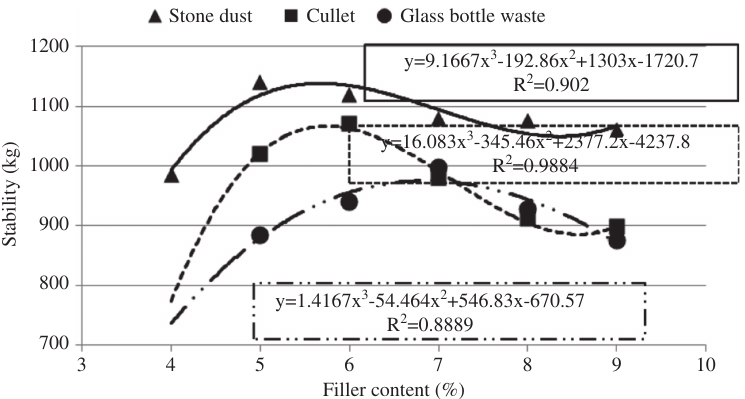
Figure 5 Relationship between Marshall stability and filler